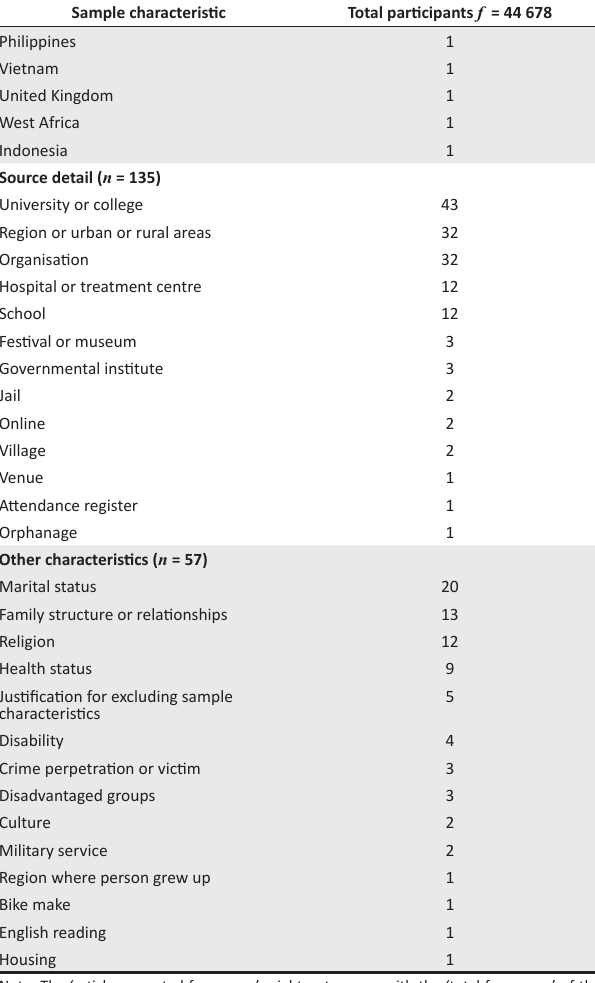
TABLE 4: Convenience sample participants’ characteristics. Sample